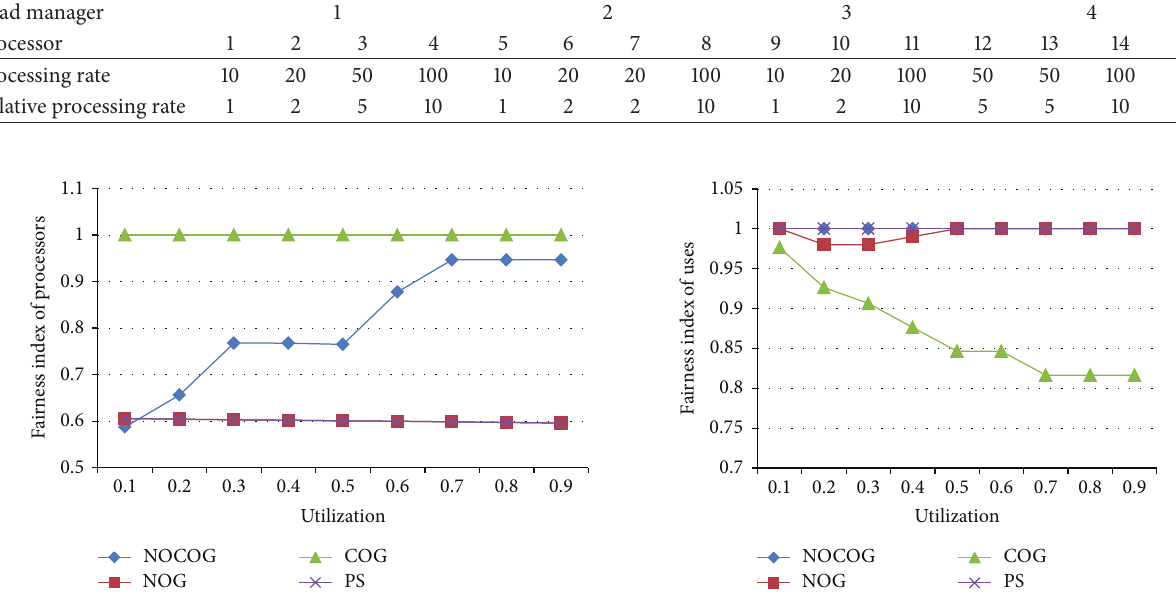
Figure 3: Fairness index versus utilization of computing center.